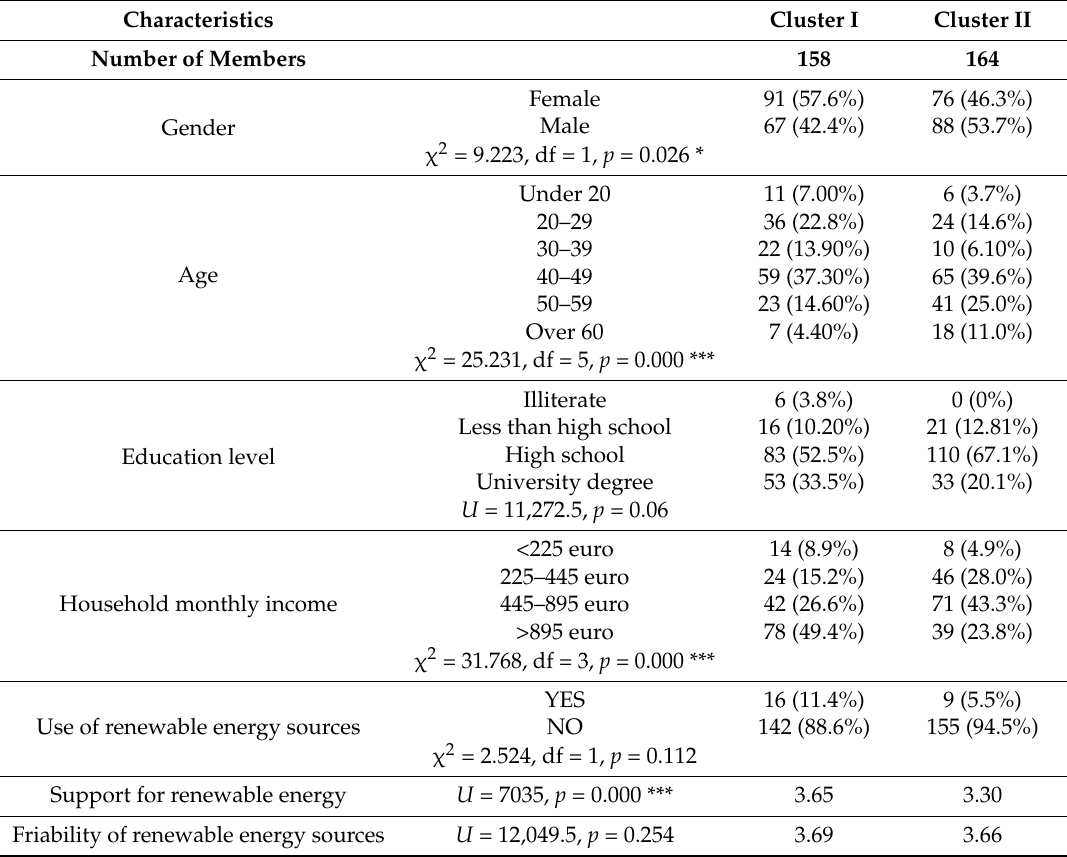
Table 6. Characteristics of segmented